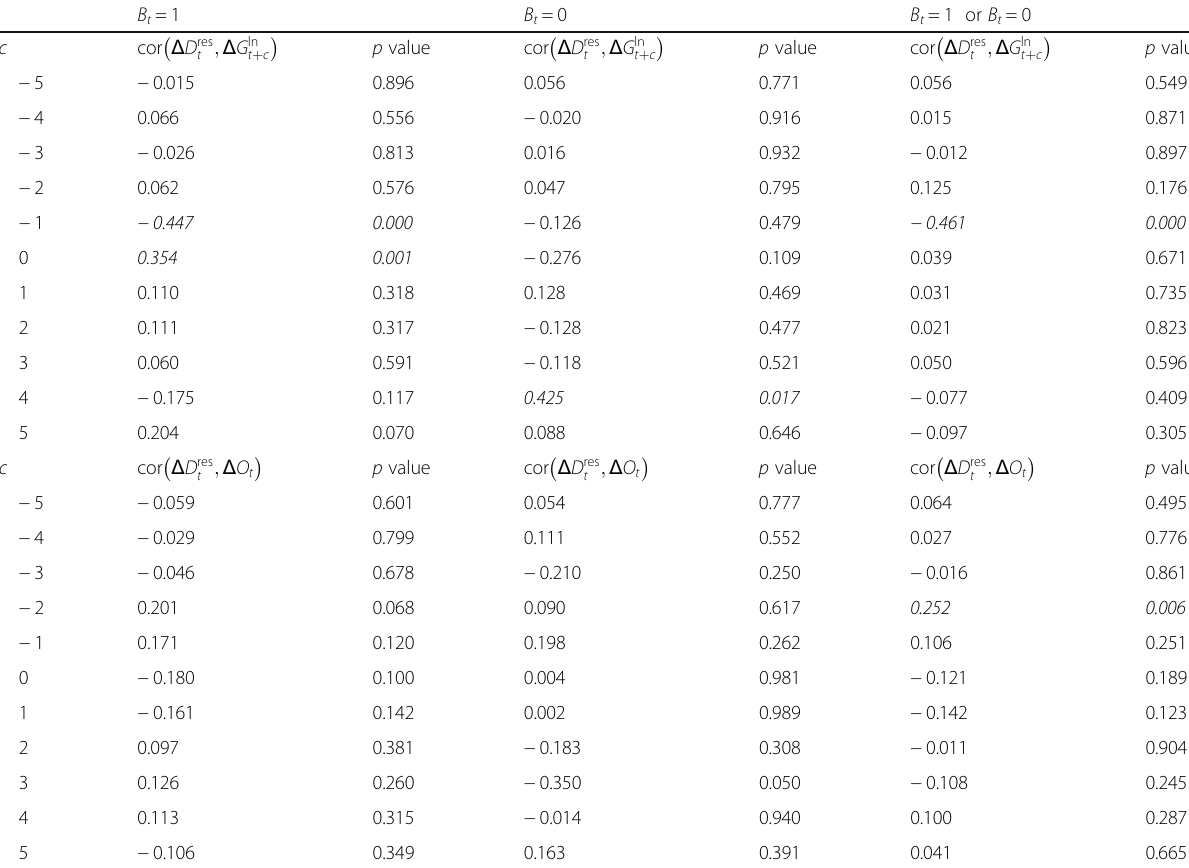
Table 2 Top: Pearson correlation coefficients between the residuals of first differences ln-debt and residuals of first differences ln-GDP for boom phases, recession phases and all data. Bottom: Pearson correlation coefficients between first differences ln-debt and residuals of first differences interest rates for boom phases, recession phases and all data. Italics: significant results with 5%